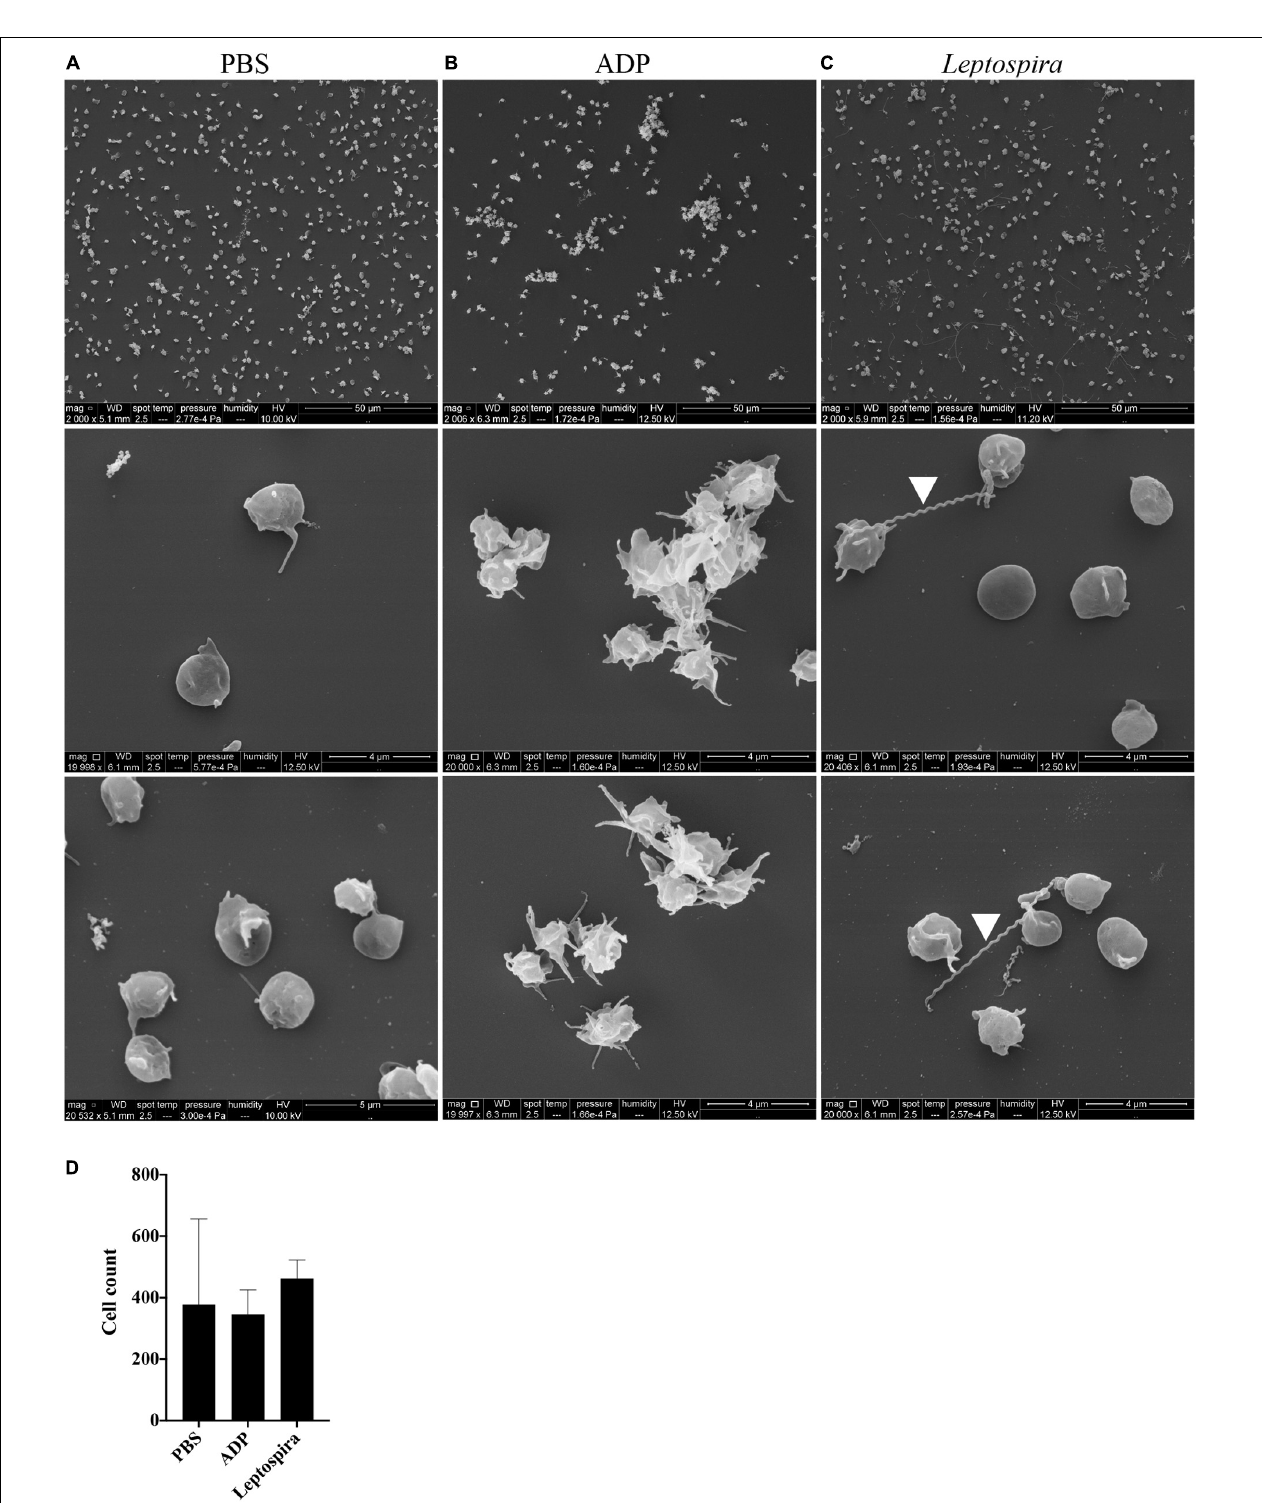
FIGURE 5 | SEM of platelets incubated in suspension with different stimuli. Washed platelets were incubated in suspension with buffer alone ( A , negative control), ADP ( B , positive control) or live virulent L. interrogans serovar Copenhageni cells (C) for 30 min. After fixation onto glass coverslips, the samples were prepared for SEM and visualized at 2,000 (upper panel) and 20,000 magnification (middle and lower panels). The figure shows representative figures of the samples. Two independent experiments were performed, with similar results. (D) Platelet count in the 2,000 magnification panels. The bars represent the mean ± standard deviation of two independent